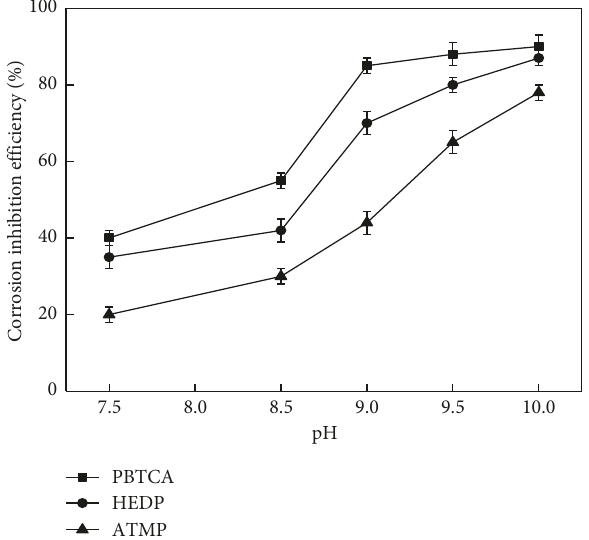
Figure 4: Corrosion inhibition rate of the corrosion inhibitor to carbon steel at different